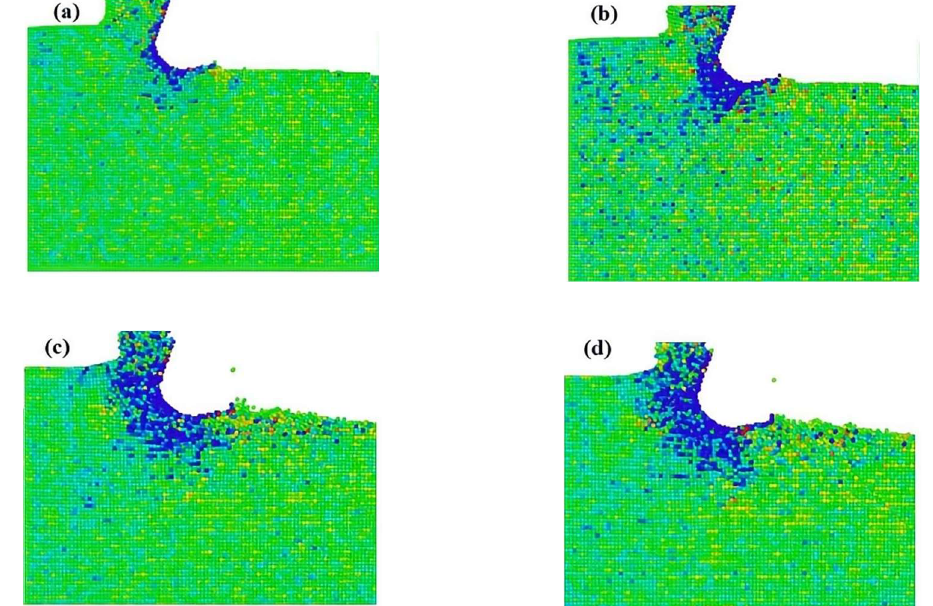
Figure 16. Internal stress distribution at different cutting speeds (( a ) cutting speed is 100 m/s and without watermedium ( b ) cutting speed is 200 m/s and without watermedium ( c ) cutting speed is 100 m/s and with watermedium ( d ) cutting speed is 200 m/s and with watermedium).